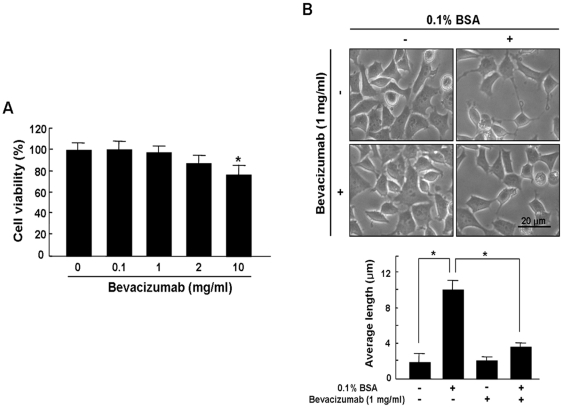
Attenuation of Neurite Outgrowth by Bevacizumab in Differentiated Retinoblastoma Cells.(A) SNUOT-Rb1 cells were treated with 0.1 to 10 mg/ml bevacizumab. Cell viability was measured by MTT [3-(4, 5-dimethylthiazol-2-yl)-2, 5-diphenyltetrazolium bromide] assay. Quantitative analysis was performed by measuring viable cells relative to the controls. Each value represents means ± SE from three independent experiments (*P<0.05). (B) SNUOT-Rb1 cells were treated with either 0.1% BSA or 1 mg/ml bevacizumab. Neurite length in differentiated retinoblastoma cells was measured by manual tracing of neurite outgrowth in each cell. The figures that appear here were selected as representative of data from three independent experiments. Quantitative analysis was performed using average length from total neurites measured. Each value represents means ± SE from three independent experiments (*P<0.05). Scale bar, 20 µm. BSA, bovine serum albumin.